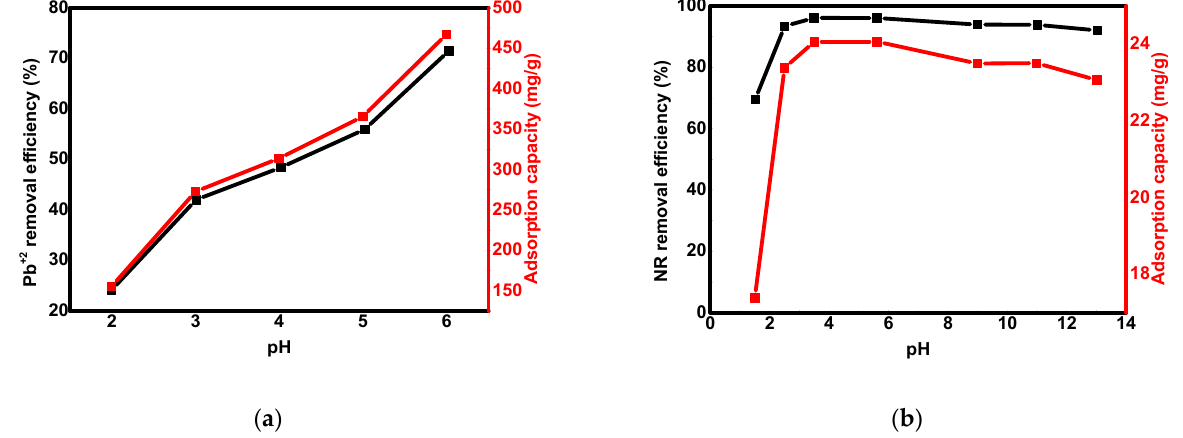
Figure 6. The effect of pH on Pb 2+ ions ( a ) and NR dye ( b ) adsorption over MnFe 2 O 4 /GO nanocomposite.